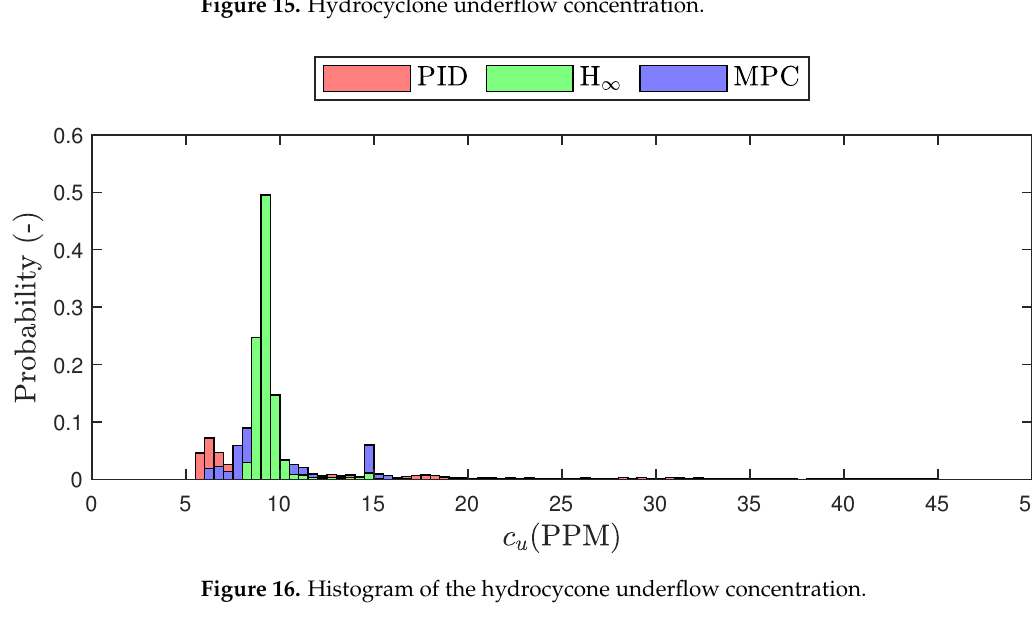
Figure 15. Hydrocyclone underflow concentration.